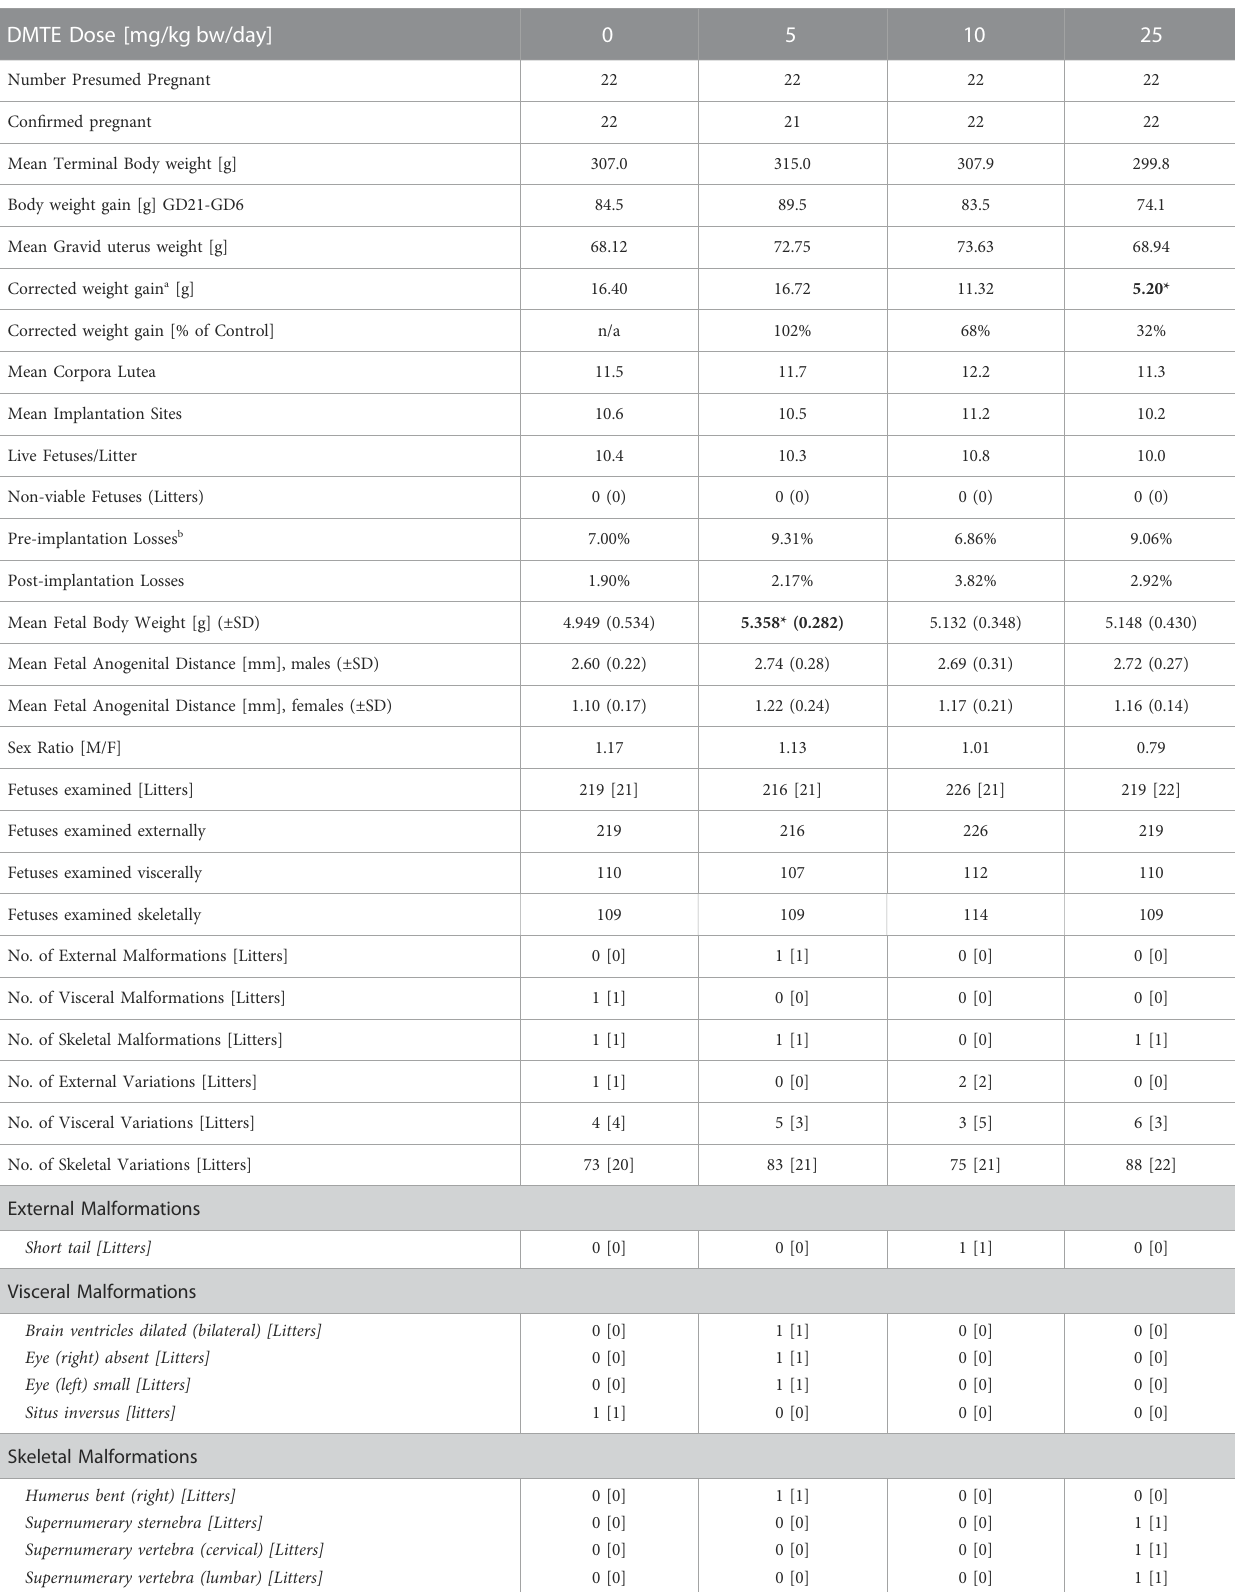
TABLE 3 Maternal reproductive success and fetal development of rats exposed to